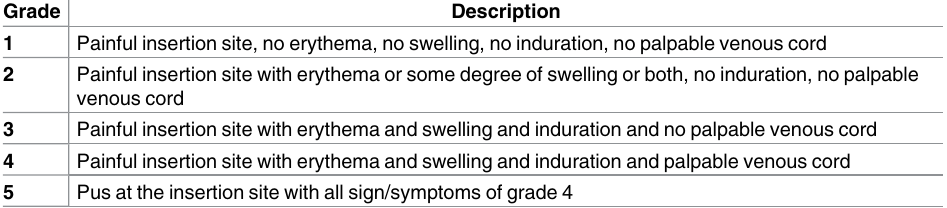
Table 1. Criteria for judging phlebitis based on Ray R. Maddox phlebitis grading scale [17] with minor modifications * .